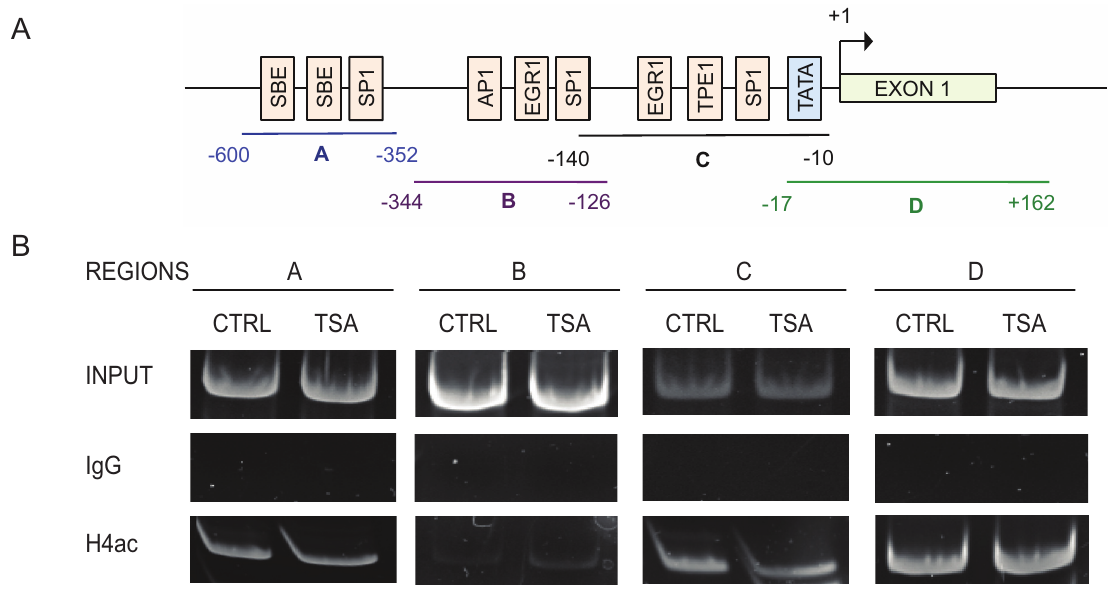
Figure 6. TSA does not impact TTP promoter histone acetylation. ( A ) Schematic representation of the ZFP36 promoter. Transcription factors binding sites and the different regions tested for ChIP (A, B, C, and D) are shown. ( B ) ChIP of acetylated histone H4 in the ZFP36 promoter. Chromatin from HCT-116 cells treated with 0.4 (cid:3)M TSA for 12 h was immunoprecipitated with anti-acetylated histone H4 or nonspecific IgG. PCR analysis of eluted DNA was performed using primers spanning regions A, B, C, and D of ZFP36 promoter as described in Experimental Section. Gels shown are representative of duplicate